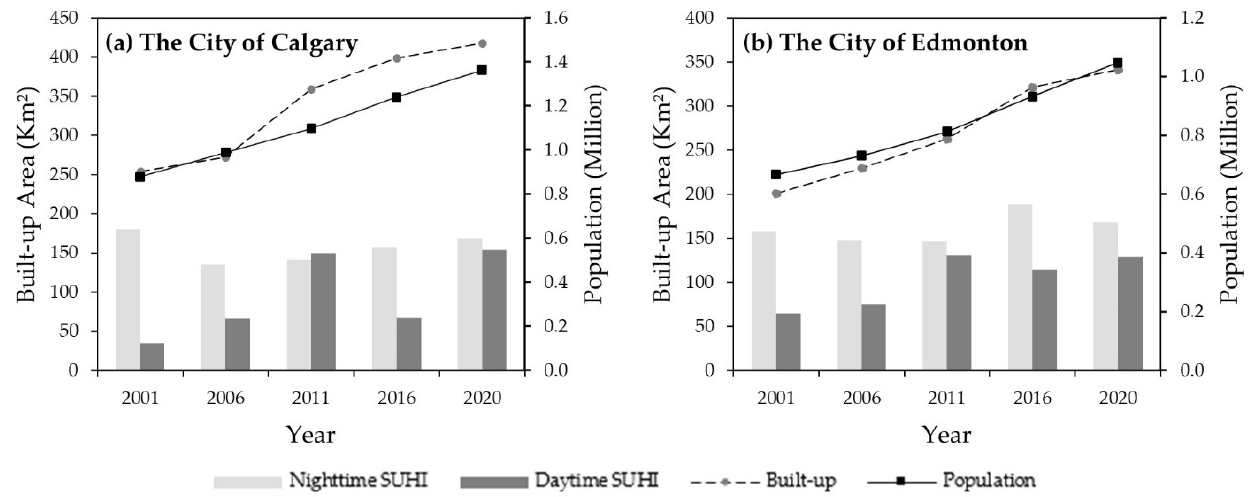
Figure 6. The relationships of SUHI with the built-up area and population for the city of Calgary ( a ) and the city of Edmonton ( b ) in the years 2001, 2006, 2011, 2016, and 2020. The correlation analysis of annual day and nighttime SUHI with the potential influ- encing factors (i.e., population, precipitation, and atmospheric oscillations—SST,